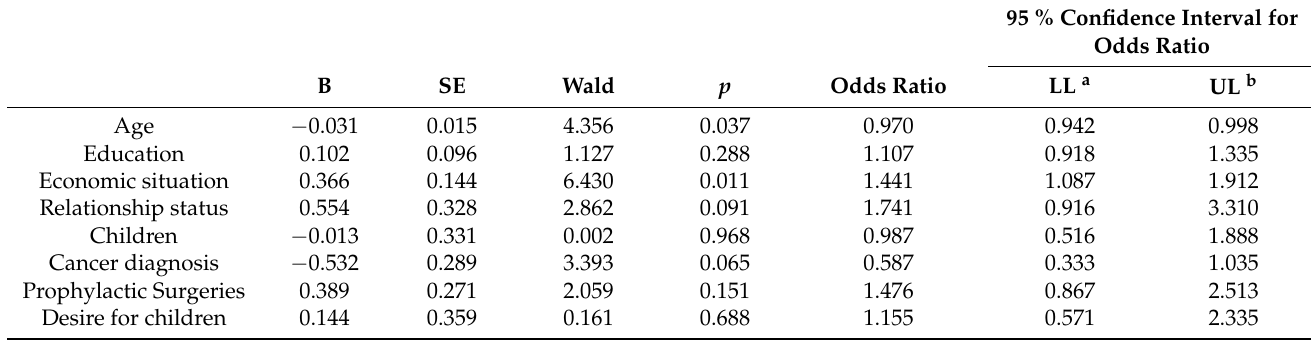
Table 3. Results of the binary logistic regression for distress ( n =